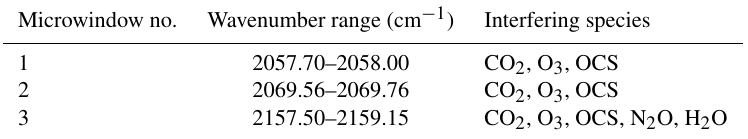
Table 1. NDACC CO microwindows and interfering species used in SFIT4 V0.9.4.4 retrievals for the PEARL-FTS.